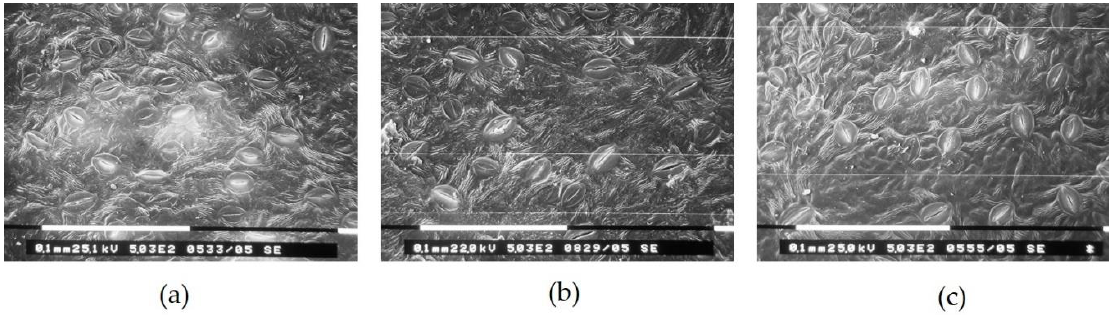
Figure 3. ( a ) Scanning electron micrograph of stomata characteristics in apple leaves under white (control), ( b ) red and ( c ) blue colored nets. Magnification 503 × . White Bars = 100 µ